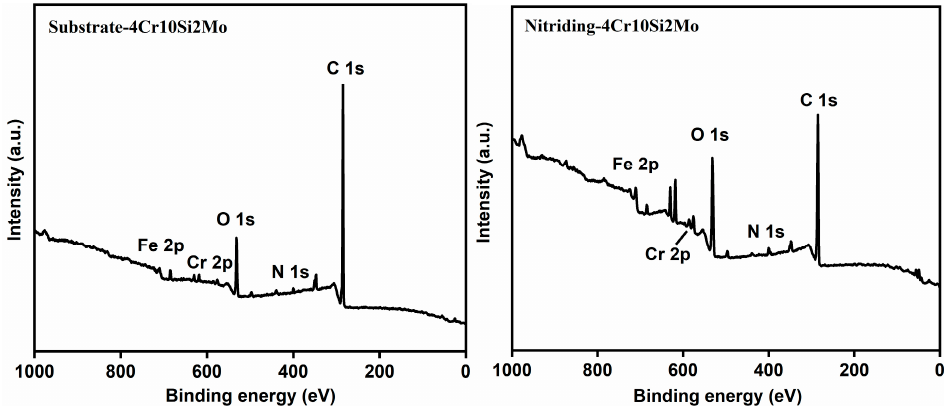
Figure 6. XPS full spectra of substrate-4Cr10Si2Mo and nitriding-4Cr10Si2Mo.